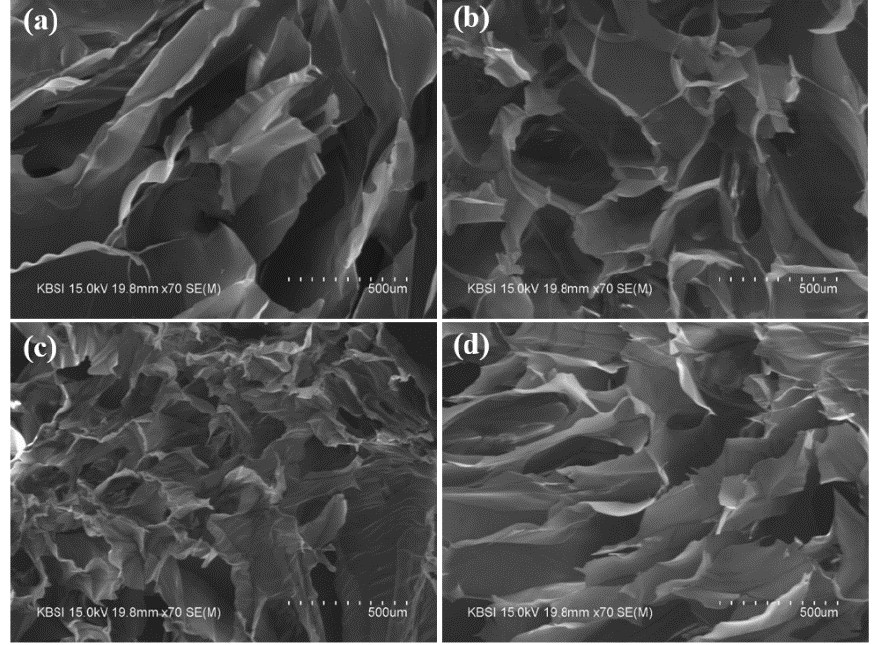
Figure 7. Field emission scanning electron microscopy (FESEM) micrographs of the fractured cross sections of ( a ) SC 6.6 , ( b ) SC 13.2 , ( c ) SC 26.4 , and ( d ) SC 52.8 .